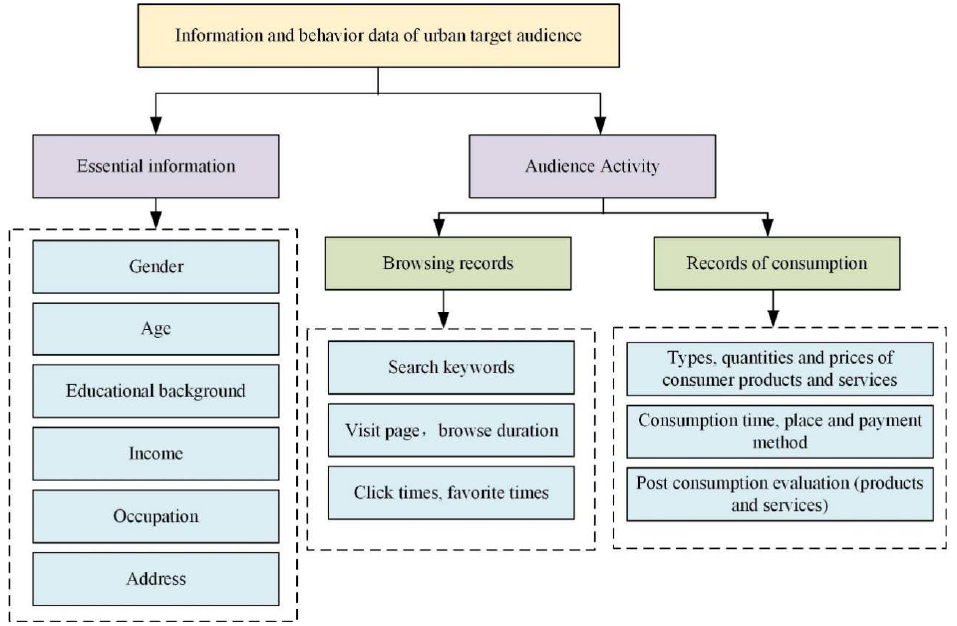
Figure 4. Information and behavior data of the city’s target audience (drawn from research analysis after reviewing the data).